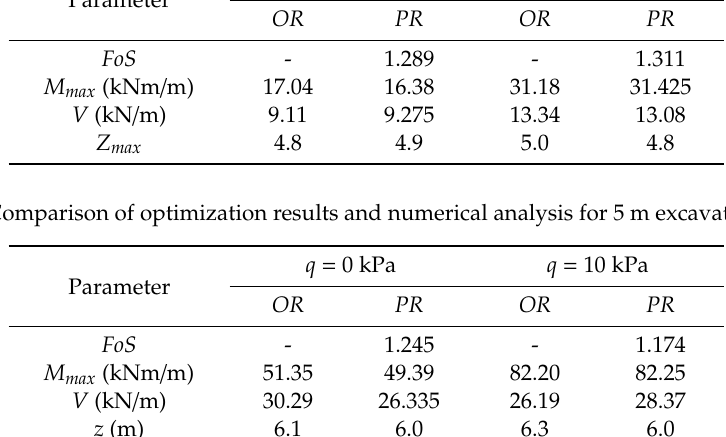
Figure 12. Effect of coefficient of soil reaction to the diameter of cantilever soldier pile ( a ), the length ( b ), and the unit cost of pile ( c ) via the excavation depth.